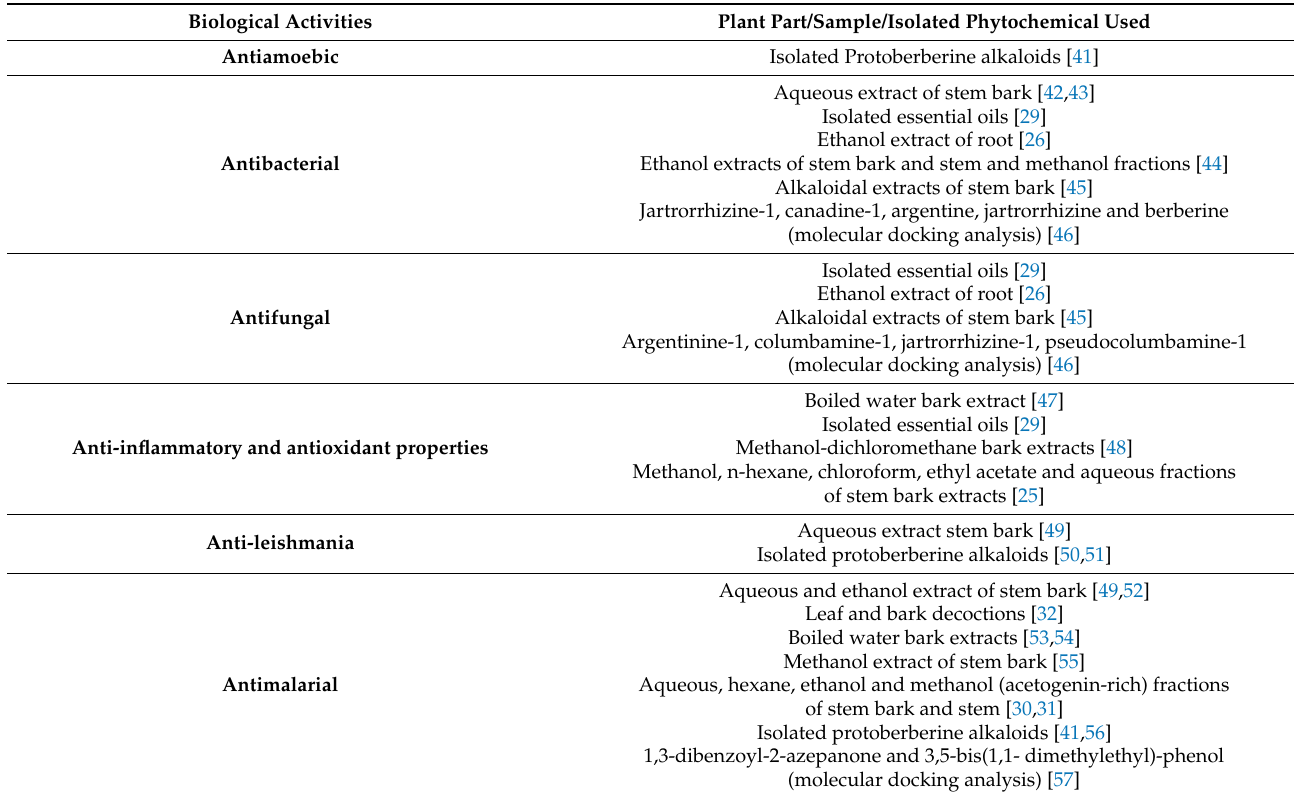
Table 1. Biological activities of extracts and compounds isolated from A. chlorantha